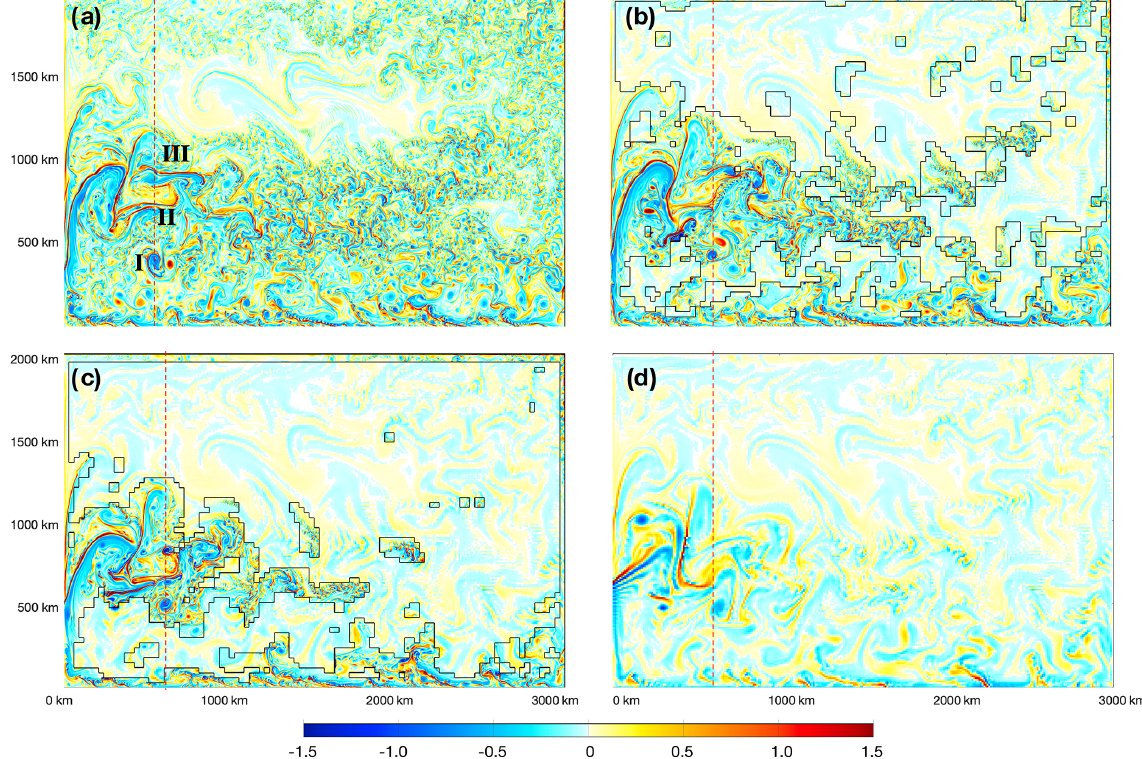
Figure 12. Same as Fig. 10 but for 50d after the refinement since 1 February. In each panel, a meridional transect is marked by a dashed red line. In order to improve the consistency of mesoscale features along these transects, in panel (a) , the location of the transect is 550km from the western boundary, and in other panels, the location is offset to the east by 50km, at 600km.